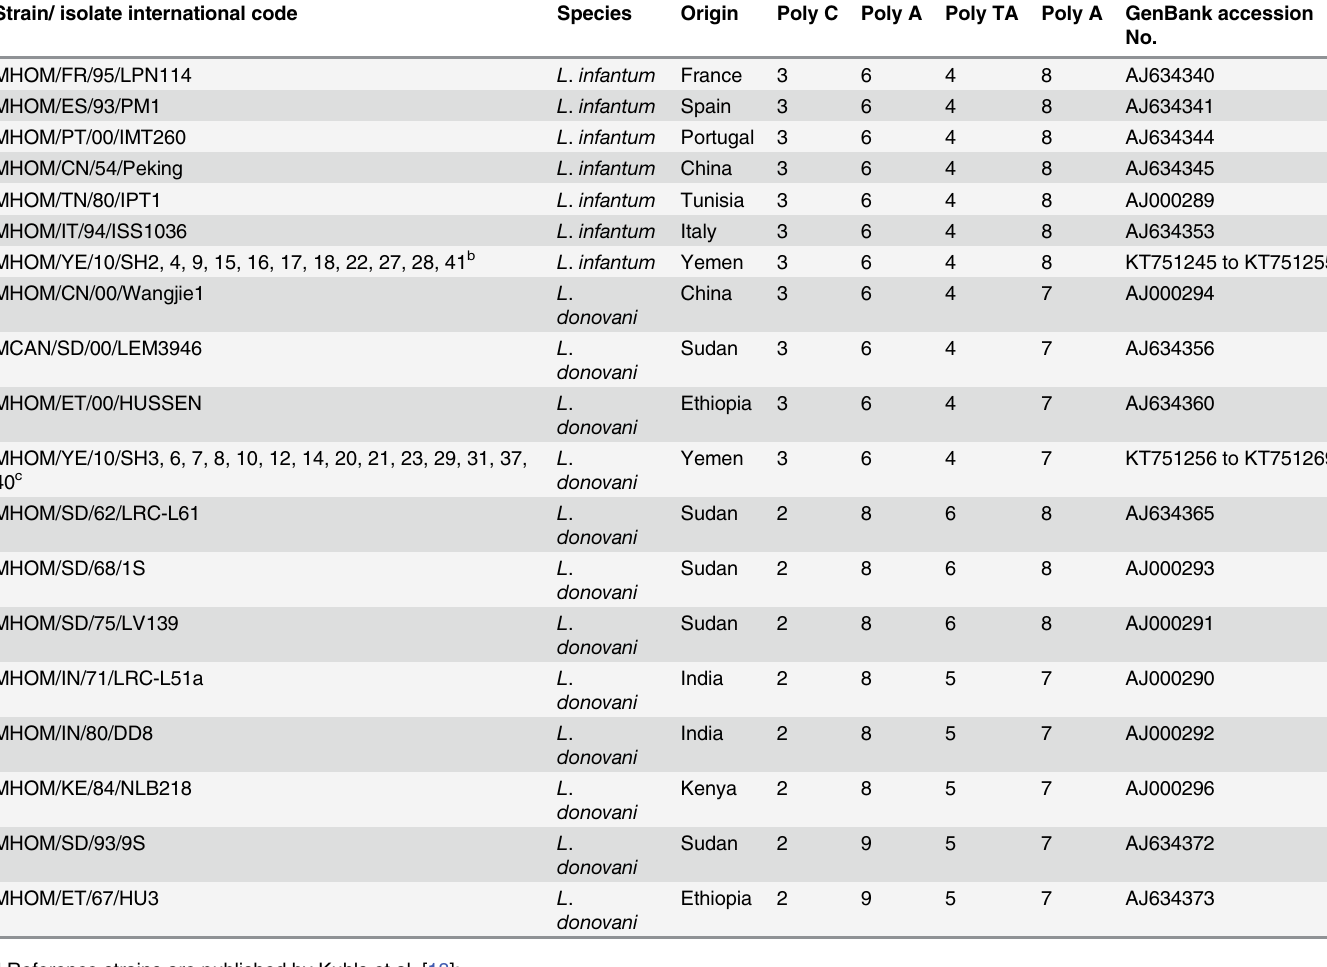
Table 1. Microsatellite repeat numbers of ITS1 gene found for L . donovani complex isolates from Yemeni children infected with VL compared to reference strains. a Strain/ isolate international